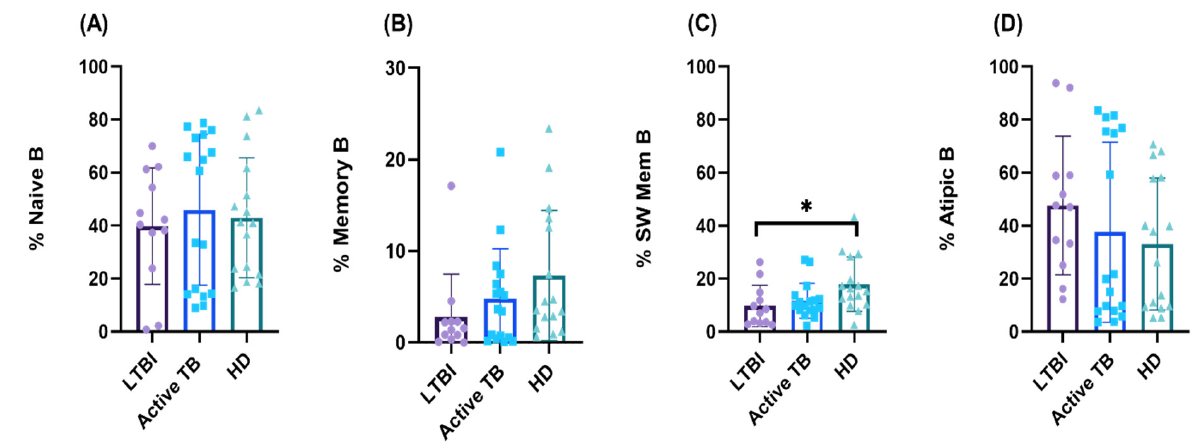
Figure 2. Phenotypic distribution frequency of Naive ( A ), Memory ( B ), Switched memory ( C ), and Atypic ( D ) B cells based on the expression of CD19, CD27, and IgD among the groups. We tested 12 LTBI, 17 Active TB, and 16 HD, as shown in the figure. The histograms represent the mean and SE of each group. Significance of differences between groups was compared using the Kruskal–Wallis test, * p < 0.05.